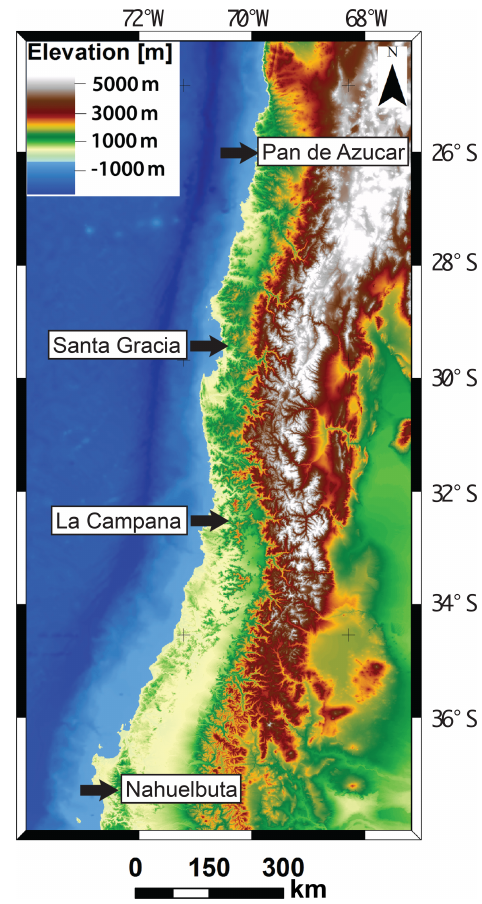
Figure 1. Digital elevation model (data source: GTOPO30) for the Chilean Coastal Cordillera and the Central Andes showing the four investigated study areas (from north to south): Pan de Azú- car ( ∼ 26 ◦ S), Santa Gracia ( ∼ 30 ◦ S), La Campana ( ∼ 33 ◦ S), and Nahuelbuta ( ∼ 38 ◦